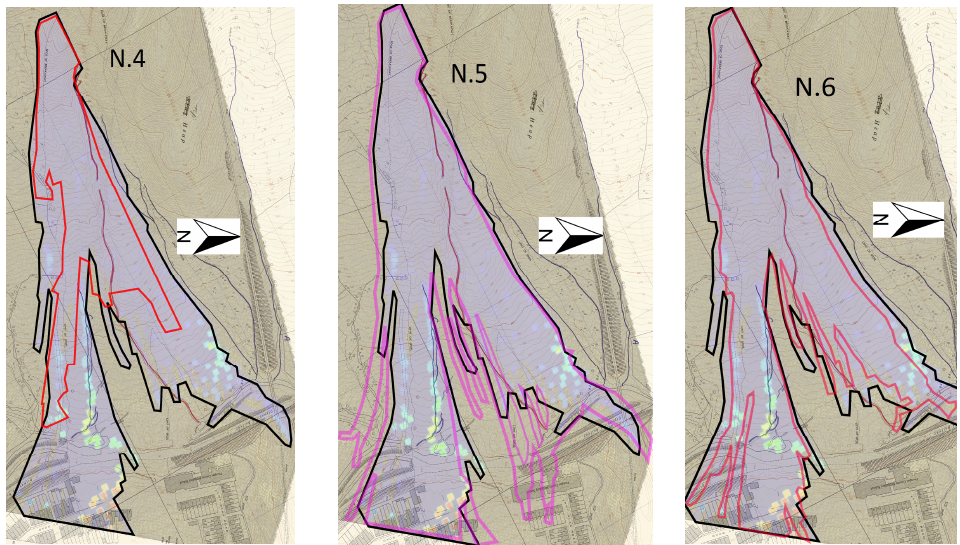
Figure 15. Propagation profiles: N.4 ( left ), N.5 ( centre ) and N.6 ( right ).